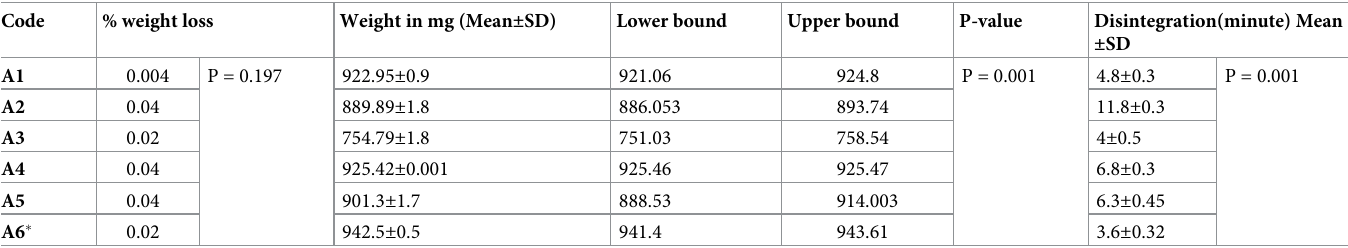
Table 5. Friability, weight variation, and disintegration test